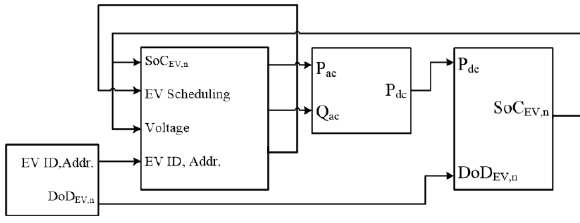
Figure 8. Architecture of EV charging model.